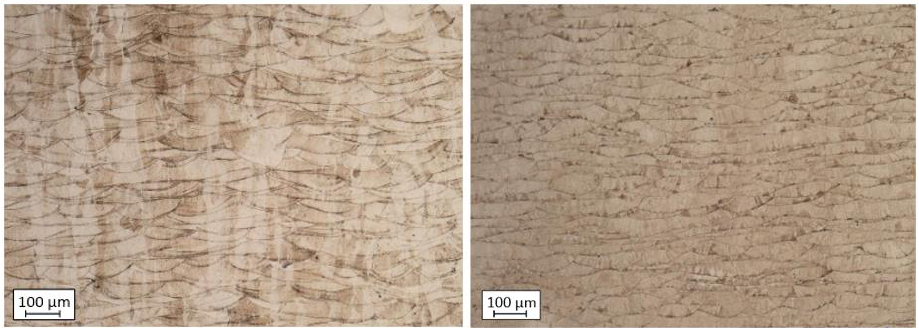
Figure 9. Microstructure of samples manufactured using both powders: left — PAGA; right — UA.